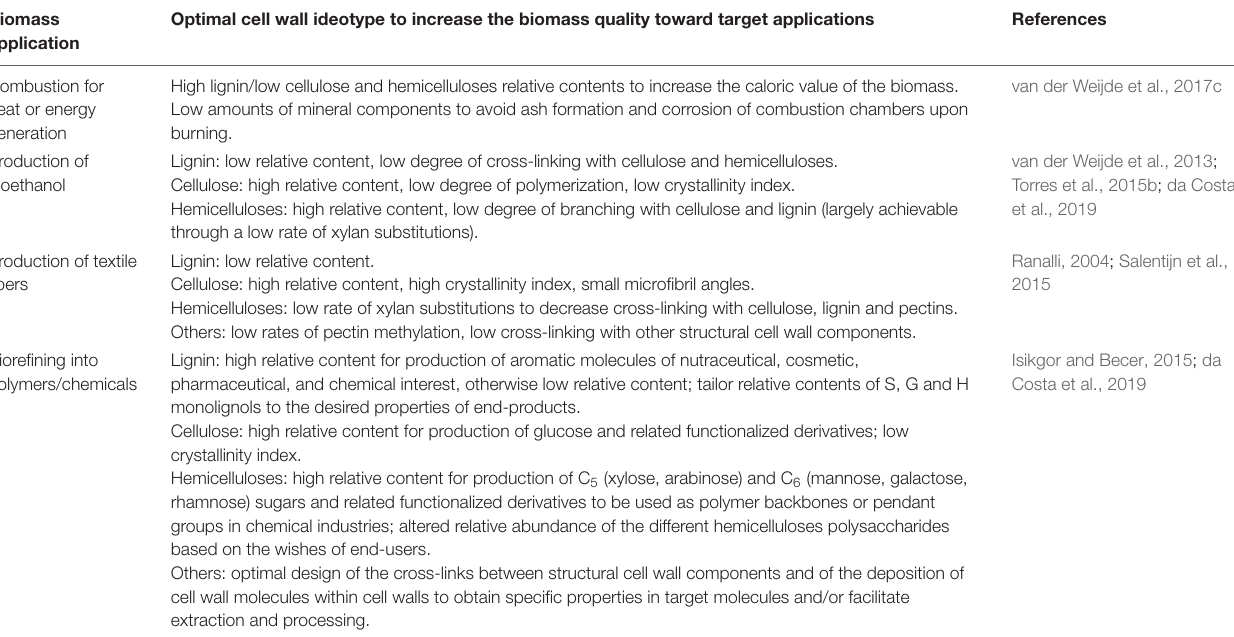
TABLE 2 | Possible end-uses of the lignocellulosic biomass obtainable from MPBCs grown on MALs and relative cell wall ideotypes to optimize biomass quality toward those applications. Biomass